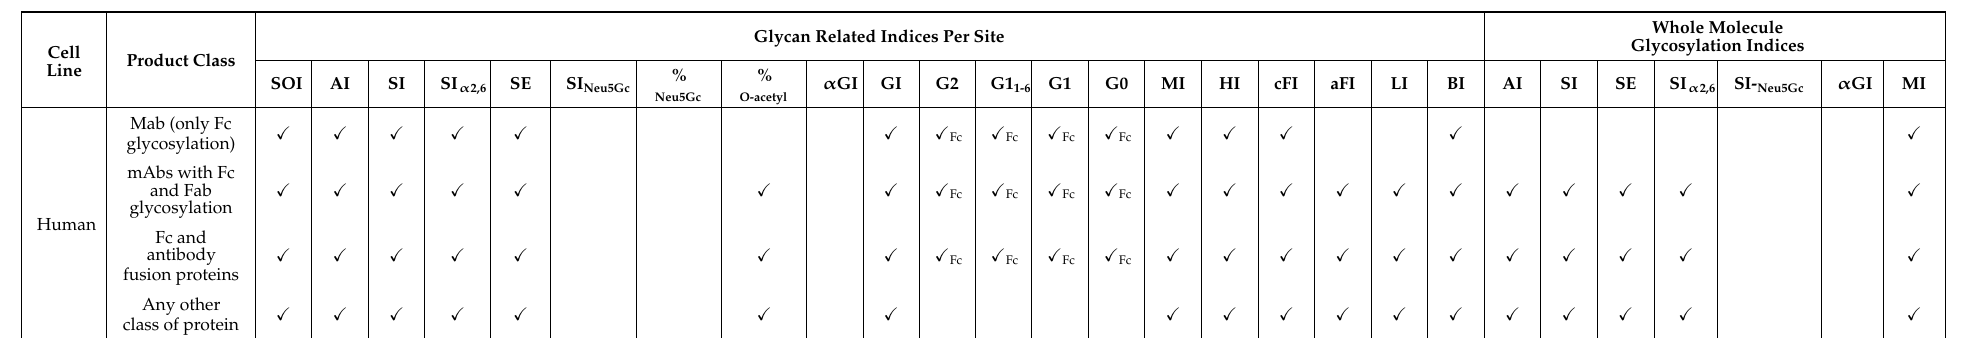
present and is obtained considering each glycoform estimated in terms of its relative percentage (%) and the number (n) of antennae present; SI : sialylation index—ponderal average number of all sialic acid residues present (Neu5Ac + Neu5Gc + O-acetylated) on complex-type and hybrid-type glycans; SI α 2,6 : sialylation index of sialic acid in α 2,6 linkage—ponderal average number of all sialic acid residues (on complex- and hybrid-type glycans) with α 2,6 linkage; SE : sialylation extent—ponderal average of the extent of sialic acid “end-capping” on terminal galactoses (on complex- and hybrid-type glycans) as a proportion of the total number of antennae present in the glycans; SI Neu5Gc : Neu5Gc sialylation index—ponderal